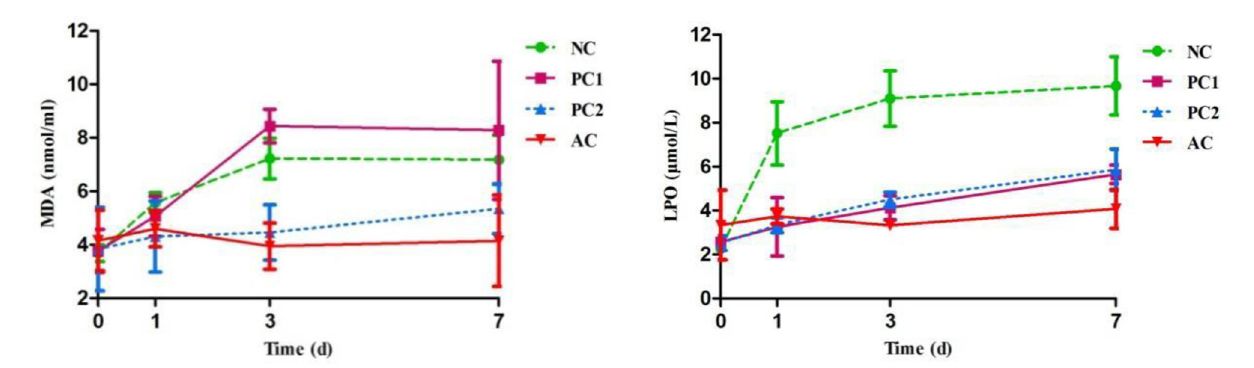
FIGURE 1 | Effect of PCP on lipid peroxidation parameters in milk during storage period. NC, negative control of no addition anthocyanins + exposure to fluorescent light; PC1, positive control 1 of no addition anthocyanins + protected from fluorescent light; PC2, positive control 2 of the addition of 0.3% (w/v) anthocyanins + exposure to fluorescent light; AC, the addition of 0.3% (w/v) anthocyanins + protected from fluorescent light; MDA, malondialdehyde; LPO, lipid